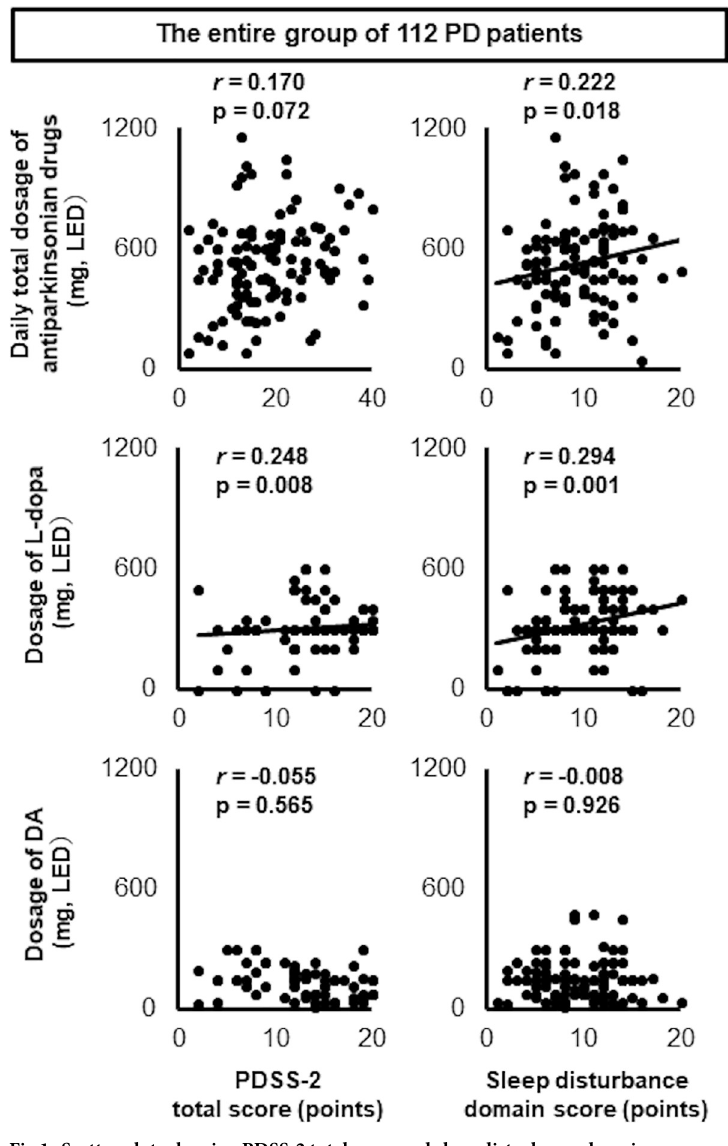
Fig 1. Scatter plots showing PDSS-2 total score and sleep disturbance domain score against drug dosage. The PDSS-2 total score was significantly correlated with the dosage of L-dopa, and the correlation coefficient was much higher than that between PDSS-2 and DAs. Among the three subdomains of the PDSS-2, the sleep disturbance domain score was significantly positively correlated with the daily total dosage of antiparkinsonian drugs and the dosage of L- dopa, with L-dopa showing higher correlation coefficients than DAs. The DA dosage was not significantly correlated with the total PDSS-2 score or the sleep disturbance domain score. P-values were calculated using Spearman’s rank correlation